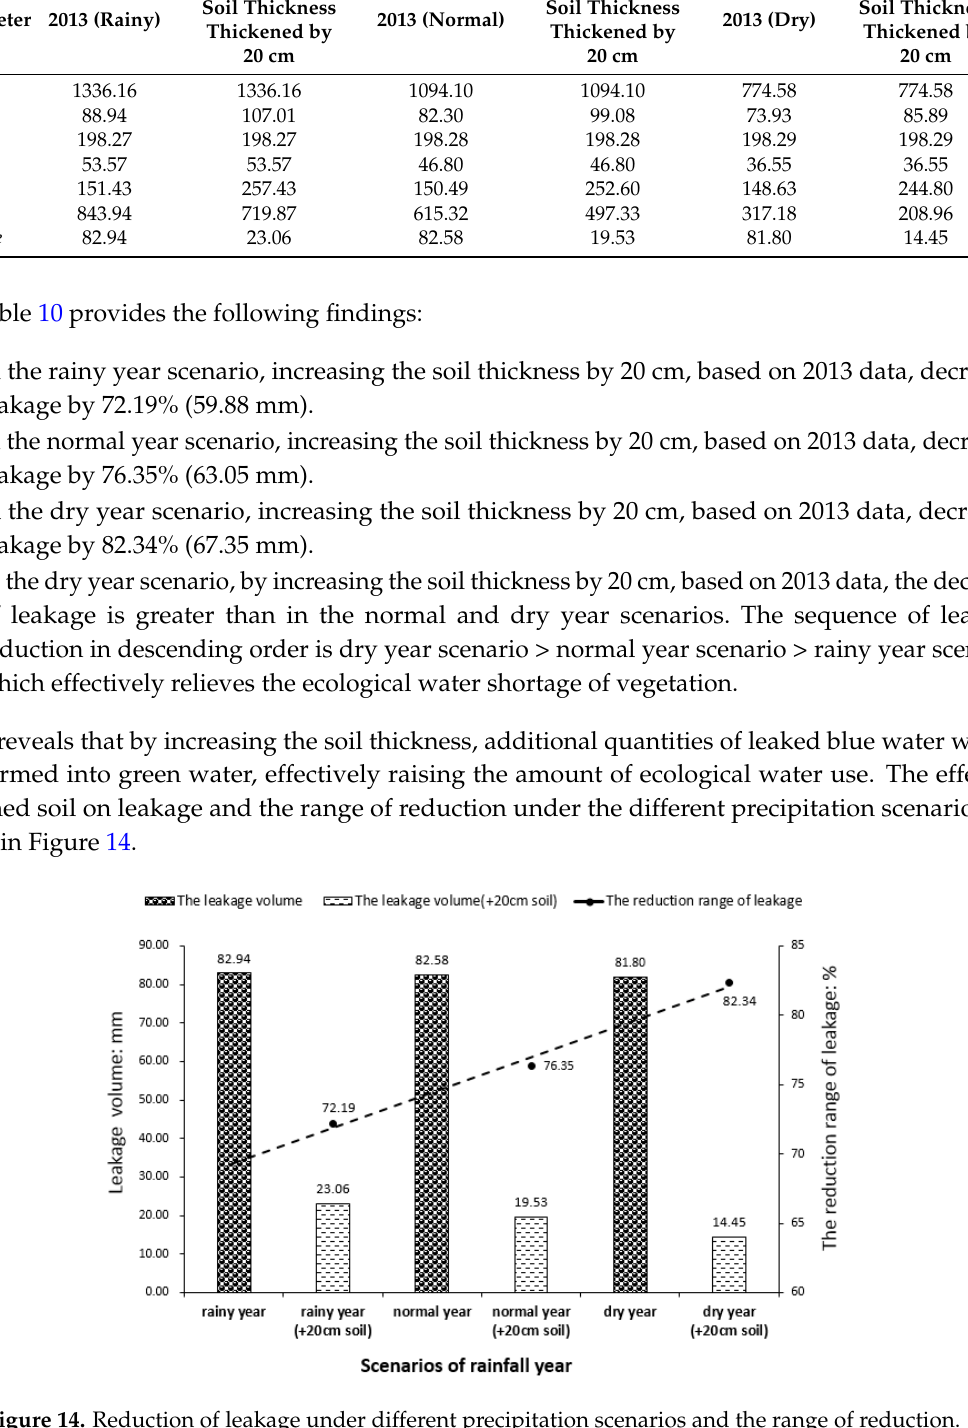
Table 10. Impact of increasing soil thickness on leakage reduction under different precipitation scenarios.